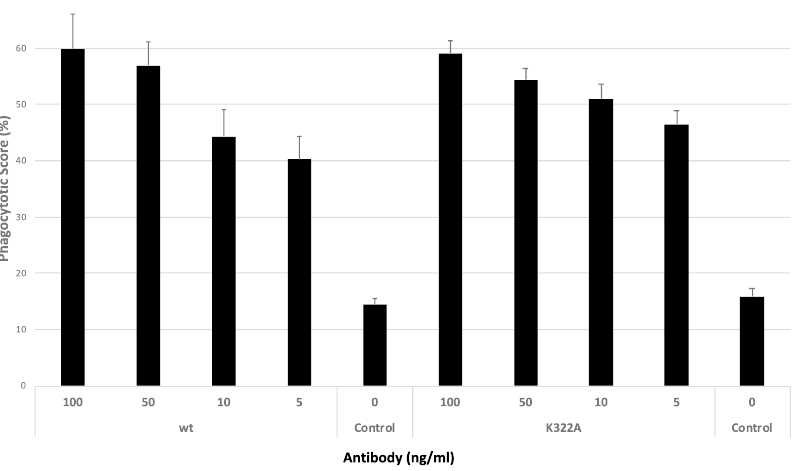
Figure 7. THP-1 Phagocytosis. Cellular uptake of PBD-C06 antibodies into human THP-1 cells was measured by flow cytometry. pE3-A β peptides coupled to fluorescent beads were first incubated with different concentrations of PBD-C06 antibodies or PBS (Control). After incubation with THP-1 cells for 24 hours, a phagocytotic score was determined as % of fluorescent cells x MFI of fluorescent cells (n = 8; + / − SD).